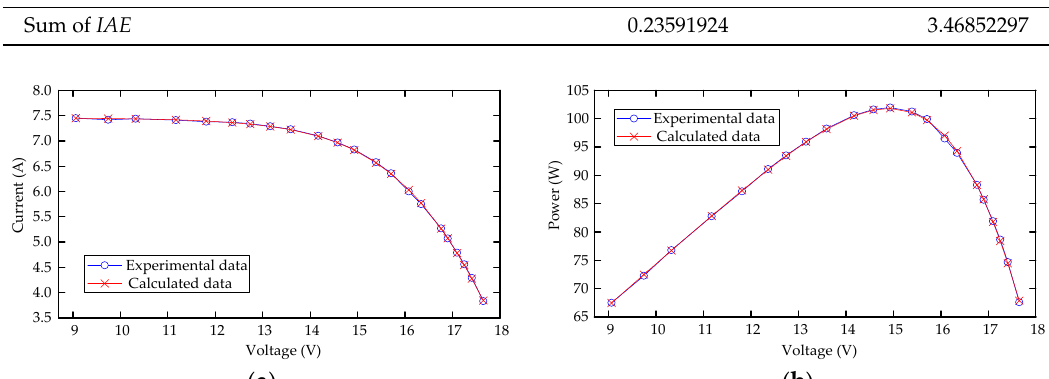
Figure 11. Comparisons between the experimental data and calculated data obtained by the proposed ImCSA for the PMM of polycrystalline STP6-120/36 panel: ( a ) I-V characteristics; ( b ) P-V characteristics.